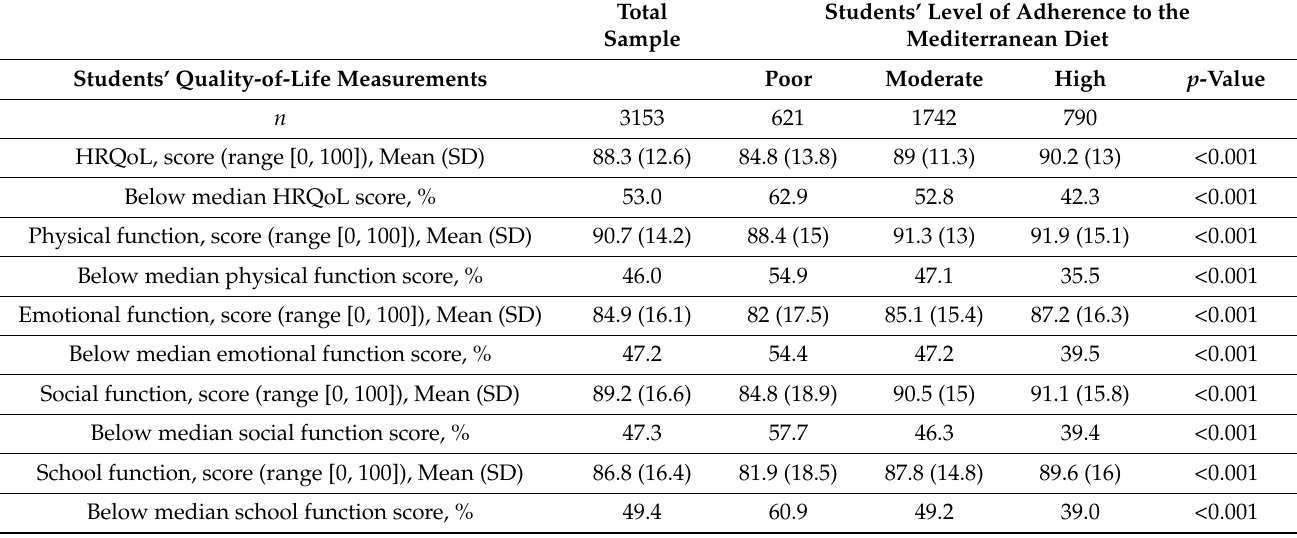
Table 2. Parent-perceived quality-of-life measurements in students according to their level of adher- ence to the Mediterranean diet at baseline.